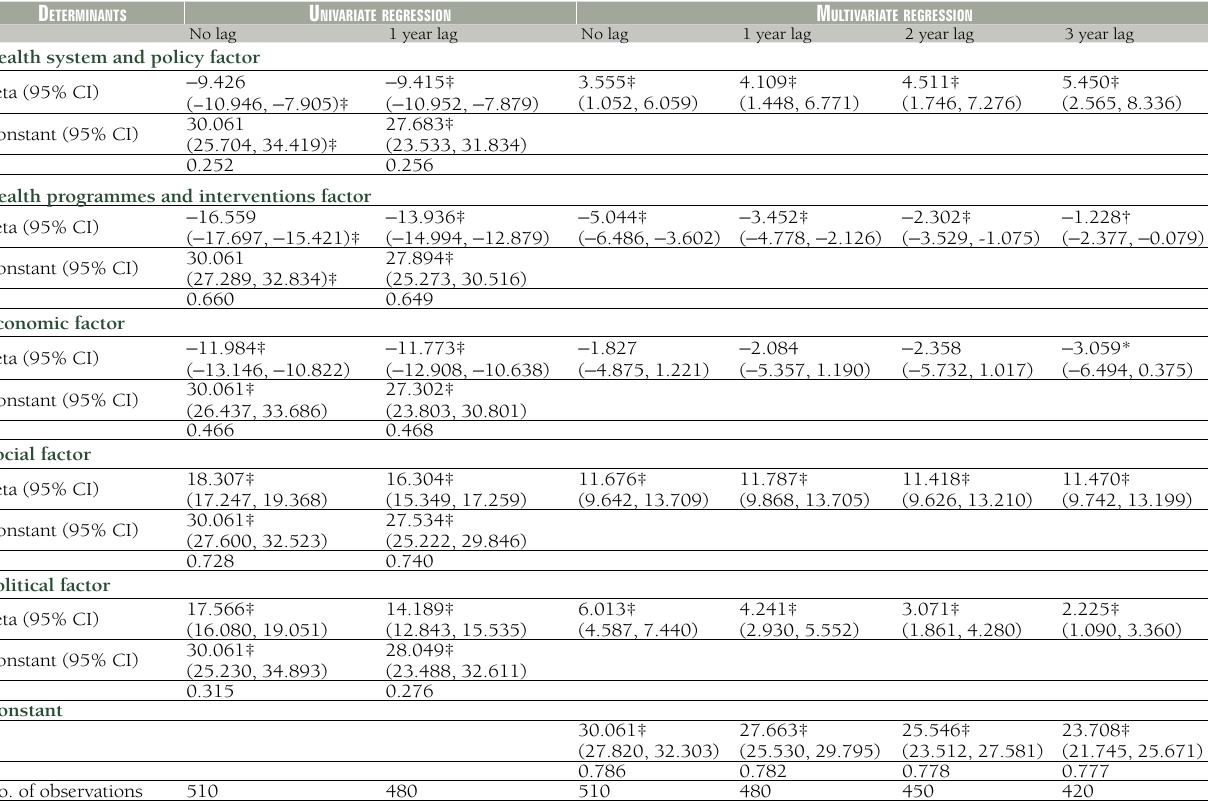
Table 2 Unadjusted and adjusted association between U5MR and the social, economic, political and health system determinants, by time